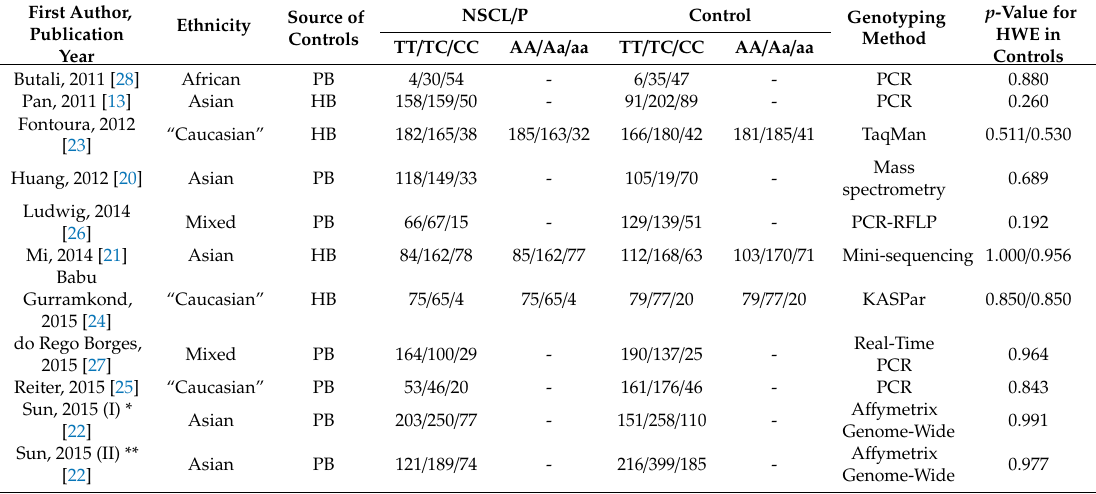
Table 1. Basic characteristics of eleven studies included in this